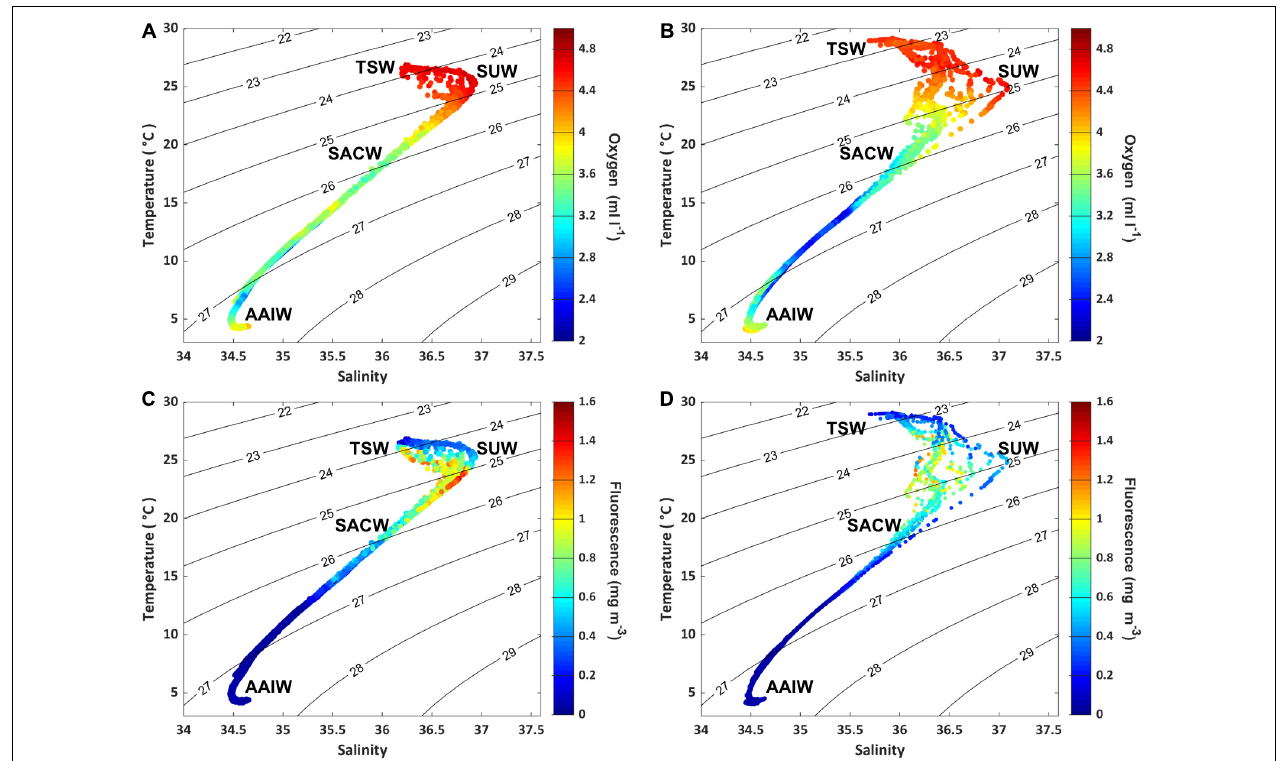
FIGURE 3 | Temperature–salinity diagram obtained from ABRACOS hydrographic stations collected during spring 2015 (A,C) and fall 2017 (B,D) around RA and FN. Color-coded for dissolved oxygen concentration (A,B) and fluorescence (C,D) . Isolines are the potential density anomaly contours referenced to the surface